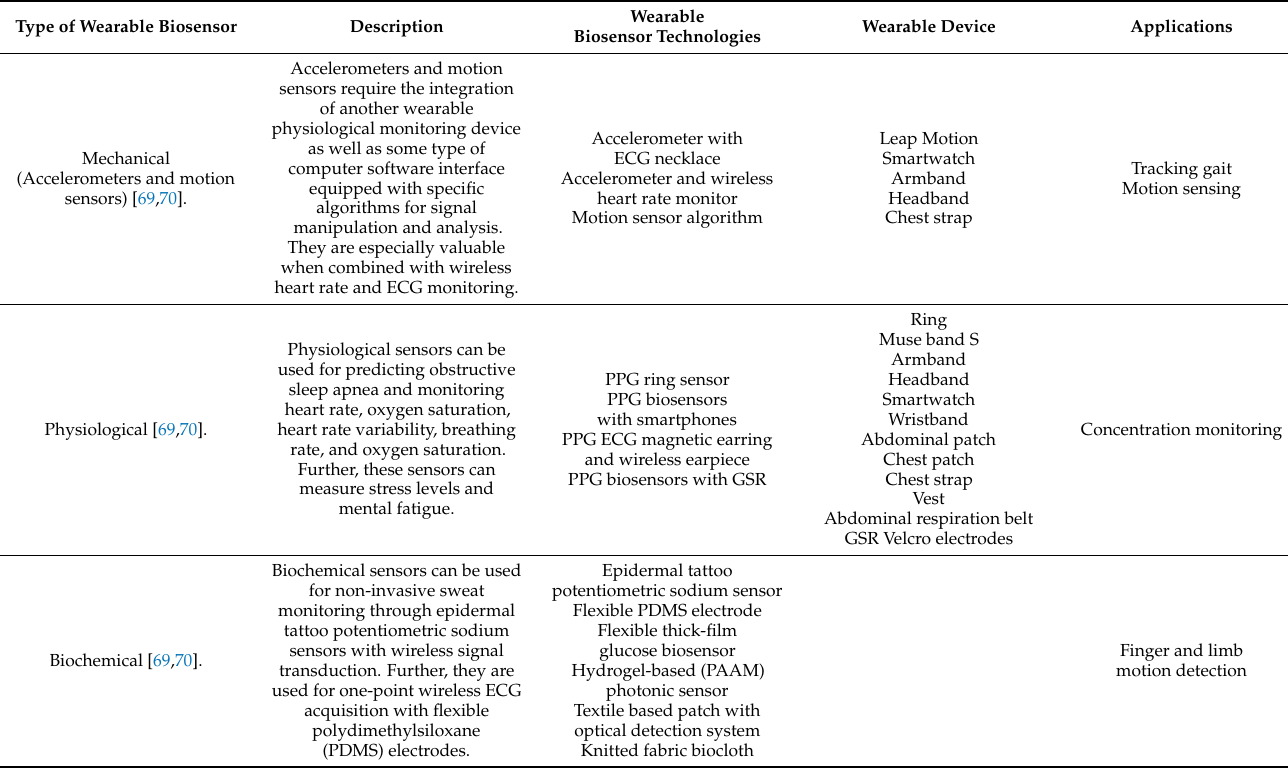
Table 1. Classification of Biosensors for Cognitive Engagement